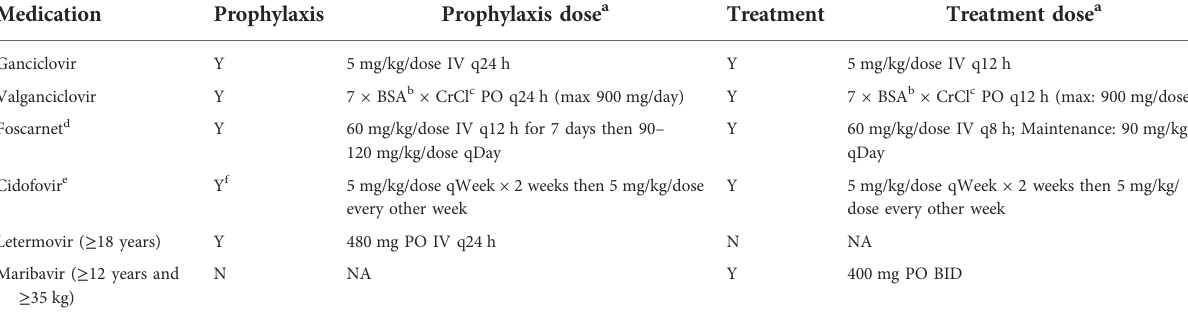
TABLE 1 Antiviral prophylaxis and treatment in pediatric HSCT recipients (27 –